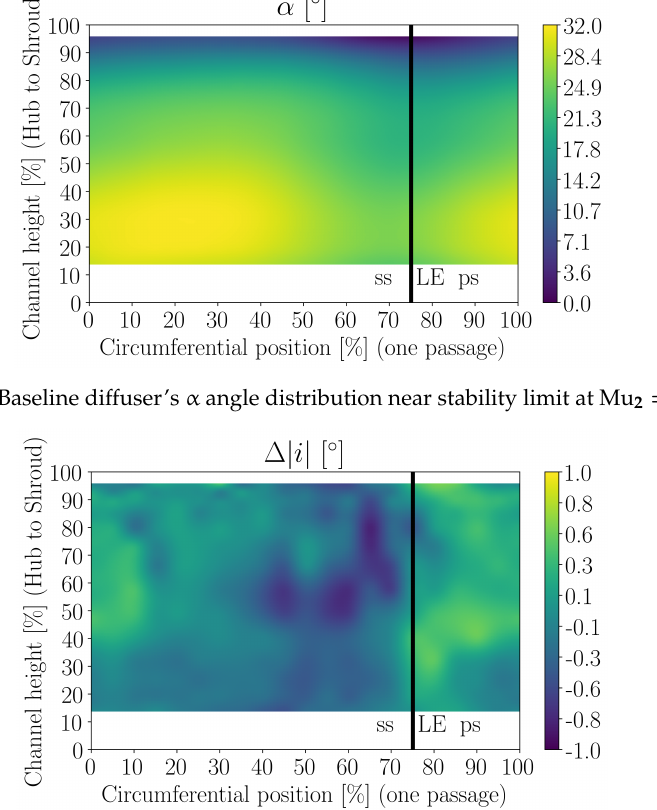
Figure 9. Improvement in incidence near stability limit at Mu 2 =